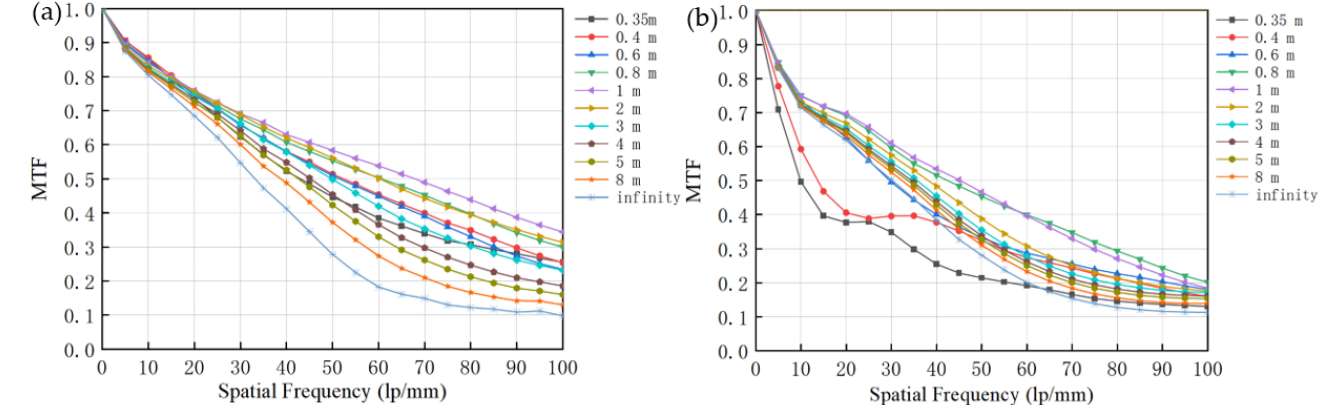
Figure 4. MTFs of the pseudophakic eye model in a 4° field for 11 object locations. ( a ) Under a pupil diameter of 3 mm. ( b ) Under a pupil diameter of 4.5 mm.